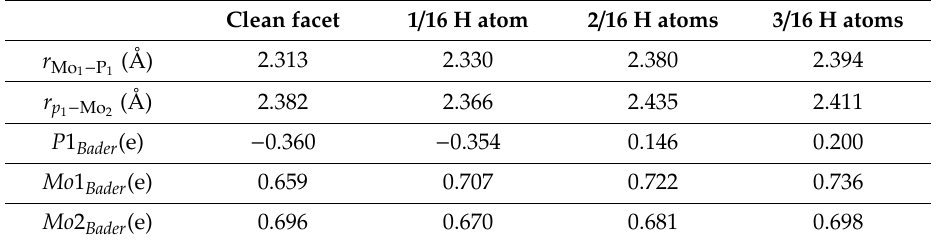
Figure 5. The charge density di ff erences for the adsorbed H atoms with H coverage of ( a ) 1 / 16, ( b ) 2 / 16 and ( c ) 3 / 16. Top and bottom panels represent overlooking and sidelooking, respectively. Color codes for Mo, P and H are dark green, purple and brown, respectively. Charge accumulation and depletion are plotted by the yellow and light blue regions with the isosurface value of 1.5 × 10 − 3 e / bohr 3 . Table 3. Bond lengths and partial atomic charges from Bader analysis with H coverage of 1 / 16, 2 / 16 and 3 / 16.